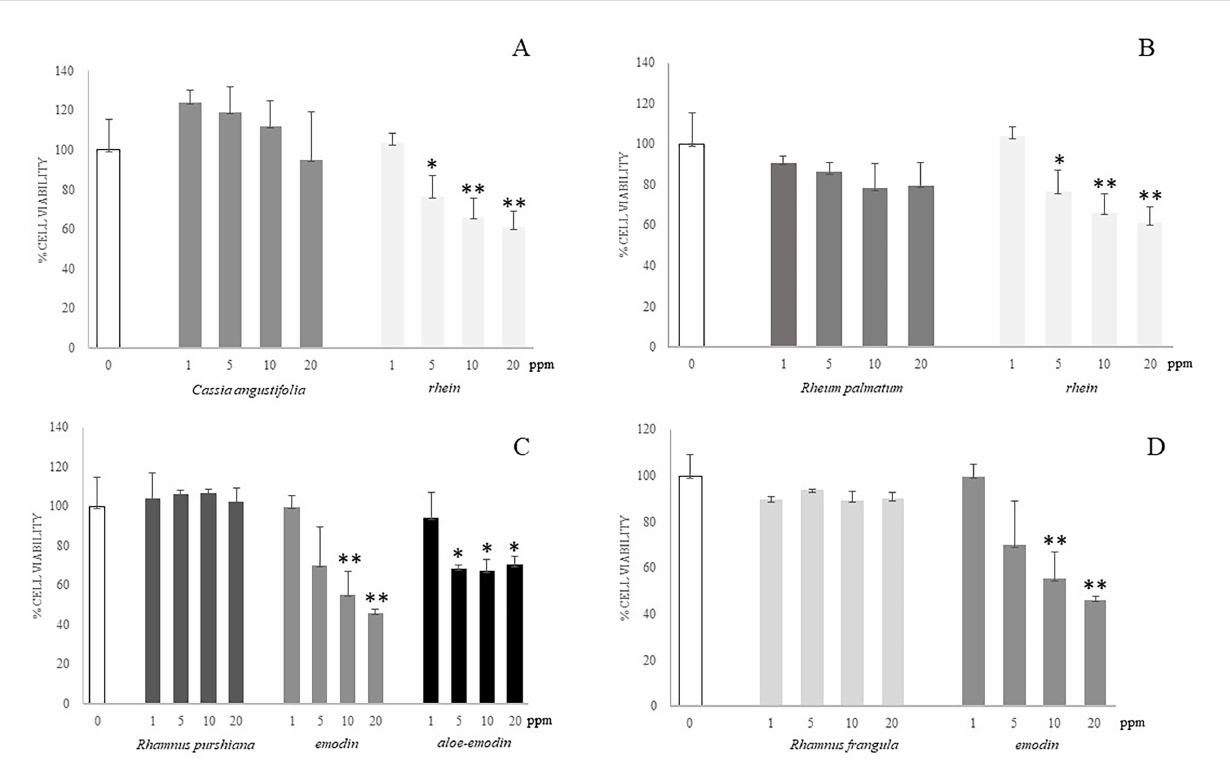
FIGURE 7 Cell viability of Caco-2 cells at different concentrations of different plant extracts and isolated compounds by alamarBlue viability assay. (A) Caco-2 cells were incubated for 48 h with different concentrations (1 – 20 ppm) of single molecule (rhein) or plant extract ( Cassia angustifolia ) at the same concentrations (1 – 20 ppm). (B) Caco-2 cells were incubated for 48 h with different concentrations (1 – 20 ppm) of single molecule (rhein) or plant extract ( Rheum palmatum ) at the same concentrations (1 – 20 ppm). (C) Caco-2 cells were incubated for 48 h with different concentrations (1 – 20 ppm) of single molecules (emodin and aloe-emodin) or plant extract ( Rhamnus purshiana ) at the same concentrations (1 – 20 ppm). (D) Caco-2 cells were incubated for 48 h with different concentrations (1 – 20 ppm) of single molecule (emodin) or plant extract ( Rhamnus frangula ) at the same concentrations (1 – 20 ppm). *P ≤ 0.05; **P ≤